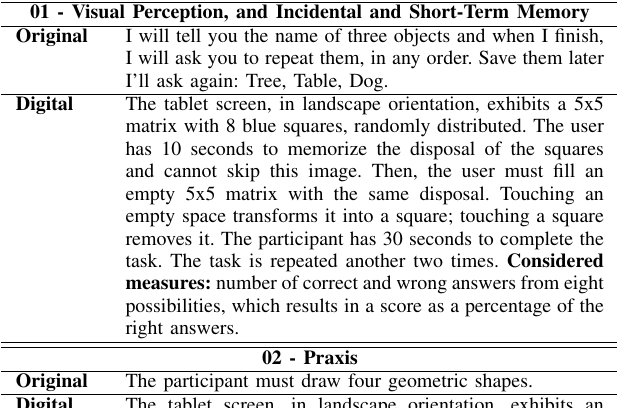
C ORRELATED ELEMENTS BETWEEN PAPER - BASED TEST AND DIGITAL